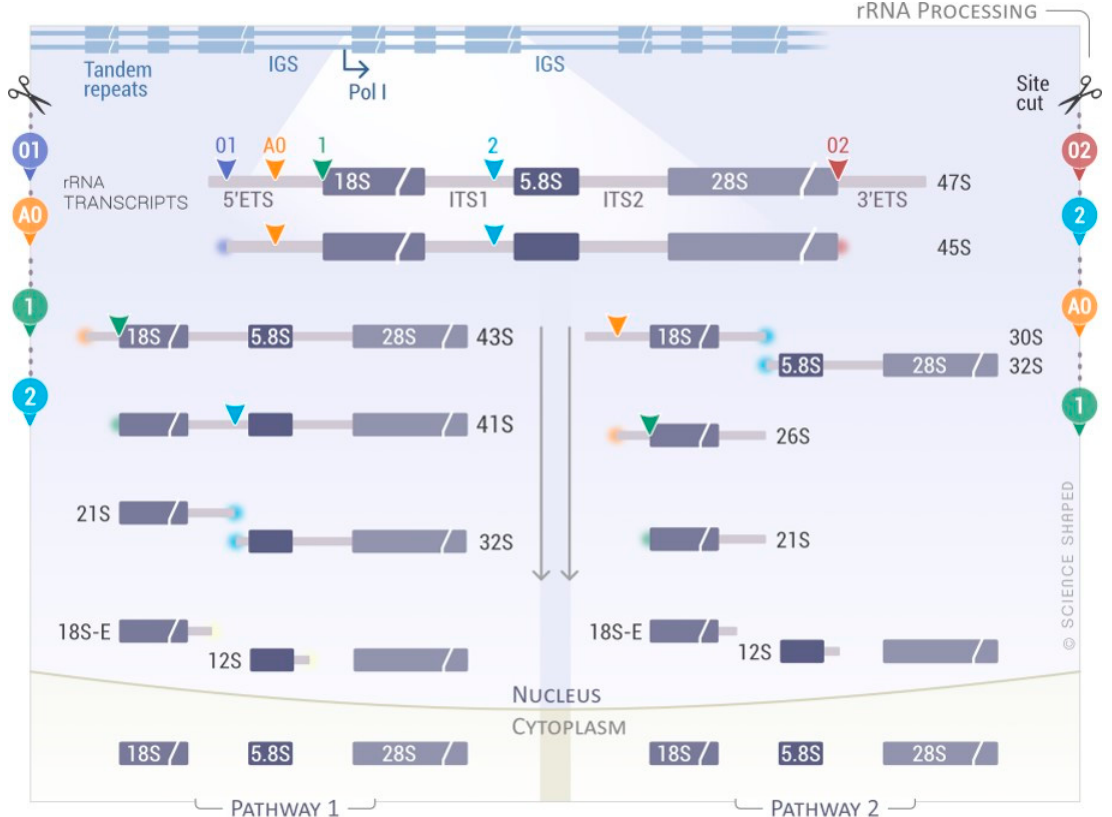
Figure 2. Simplified rRNA processing pathway in eukaryotes. RNA Polymerase I (Pol I) transcribes a long primary tran- script (47S pre-rRNA) from loci containing hundreds of rDNA copies. This transcript contains the sequences for the mature 18S, 5.8S, and 28S rRNAs flanked by external (5 ′ - and 3 ′ -ETS) and internal spacers (ITS1 and ITS2), which are enzymatically removed by endo- and exonucleases. Depending on the cleavage sites used and the kinetics, two main pathways can be depicted forming different precursors. Cleavage of the 45S rRNA precursor starts either in the 5 ′ -ETS at cleavage site 1 (Pathway 1, left side) or in the ITS1 sequence at cleavage site 2 (Pathway 2, right side). The cleavage sites used for each pathway are shown on the side.